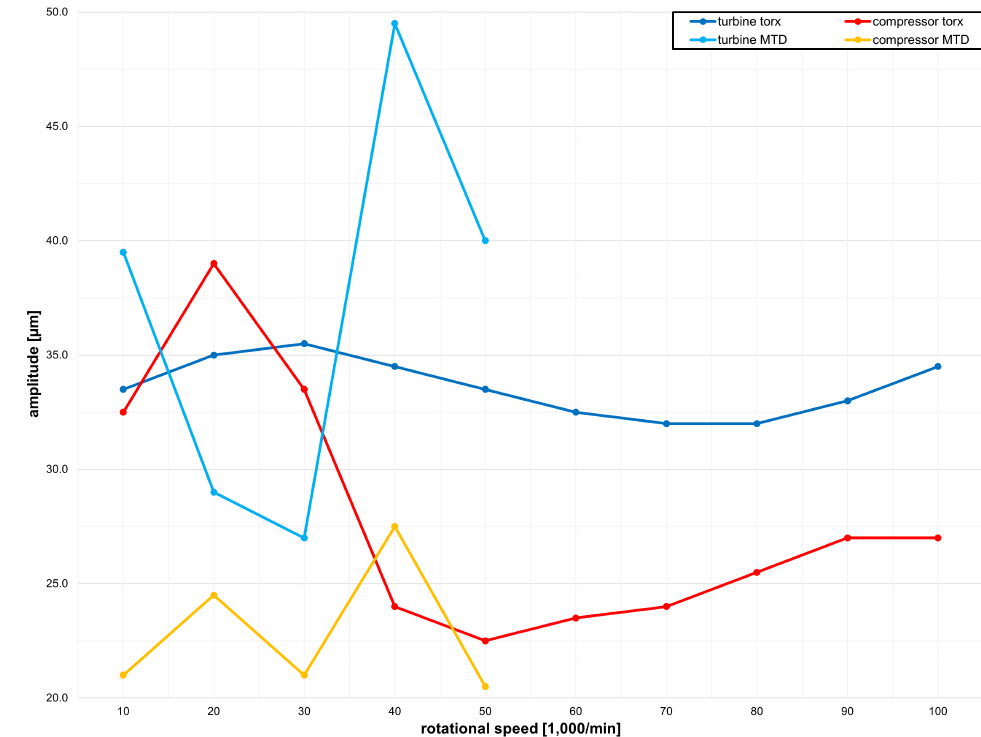
Figure 8. FTB–Comparison of torx and magnetic coupling solutions: amplitudes over rotor speed.